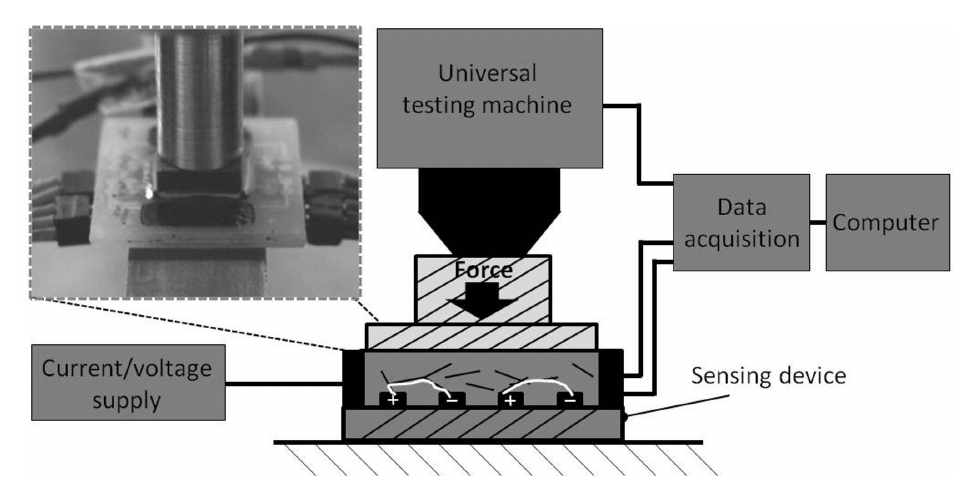
Figure 6. Force/pressure measurement